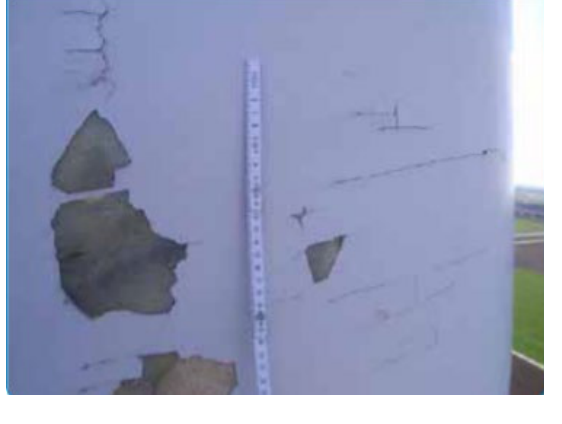
Figure 6. ( a ) Delamination, ( b ) Crack in the glue joint [29]